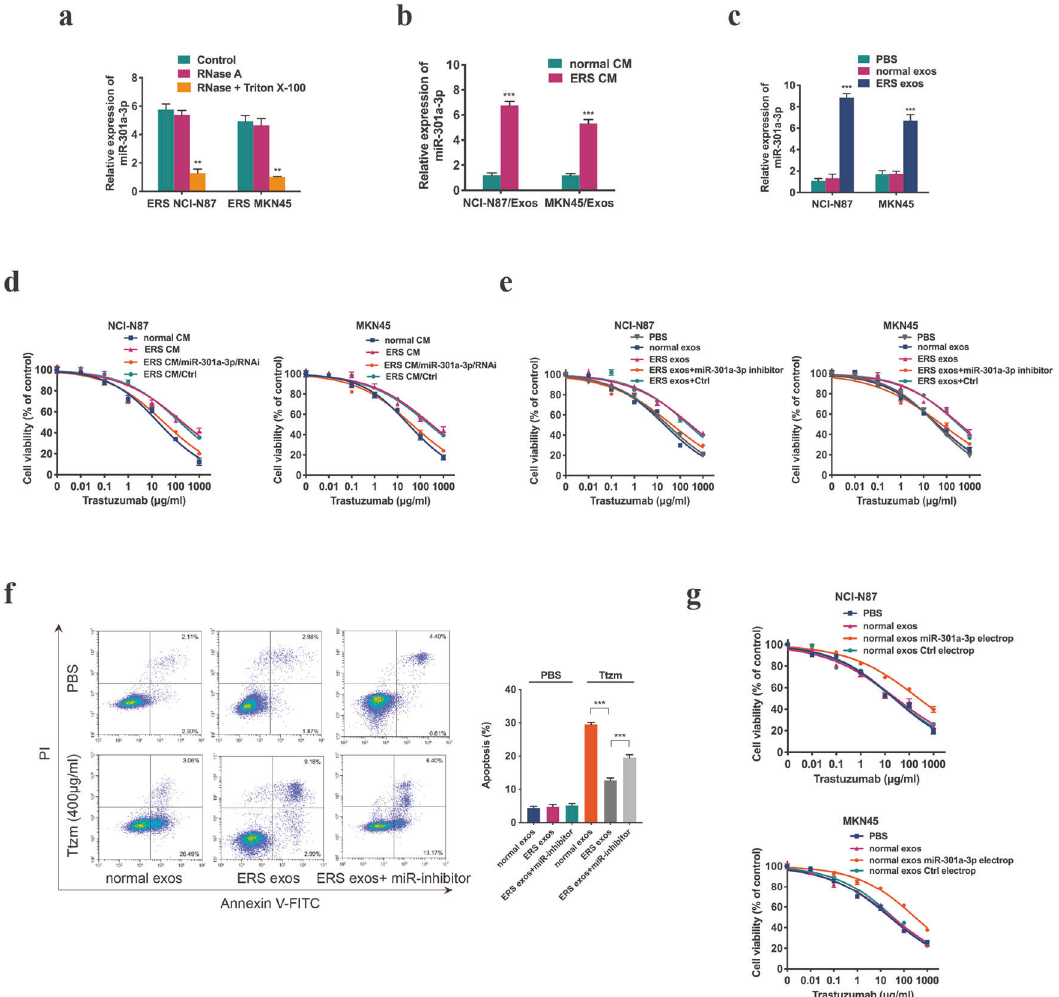
Fig. 6 Exosomes released by ER stress transmitted trastuzumab resistance through transporting miR-301a-3p in vitro. a qRT-PCR analysis of miR-301a-3p in the CM of NCI-N87 and MKN45 cells treated by 1 μ M TG for 12 h following by treatment of RNase (2 mg/ml) only or a combination of RNase and Triton X-100 (0.1%) for 20 minutes ( n = 3). b qRT-PCR analysis of miR-301a-3p in exosomes extracted from the CM of NCI-N87 and MKN45 cells treated with or without 1 μ M TG for 12 h ( n = 3). c qRT-PCR analysis of miR-301a-3p in NCI-N87 and MKN45 cells after the cells were incubated with certain exosomes (PBS as control) for 48 h ( n = 3). d CCK8 assay of NCI-N87 and MKN45 cells treated by different sources of CM for 24 h before trastuzumab treatment for 72 h ( n = 3). e CCK8 assay of NCI-N87 and MKN45 cells fi rst incubated with indicated exosomes and transfected with miR-301a-3p inhibitors or NC before trastuzumab treatment at indicated concentrations for 72 h ( n = 3). f Flow cytometry was used to measure the apoptosis of NCI-N87 and MKN45 cells incubated with indicated exosomes and transfected with miR-301a-3p inhibitors followed by 400 μ g/ml trastuzumab treatment for 72 h ( n = 3). g Exosomes isolated from NCI-N87 and MKN45 cells were electroporated with miR-301a-3p mimics or control. NCI-N87 and MKN45 cells were cultured with certain exosomes for 48 h